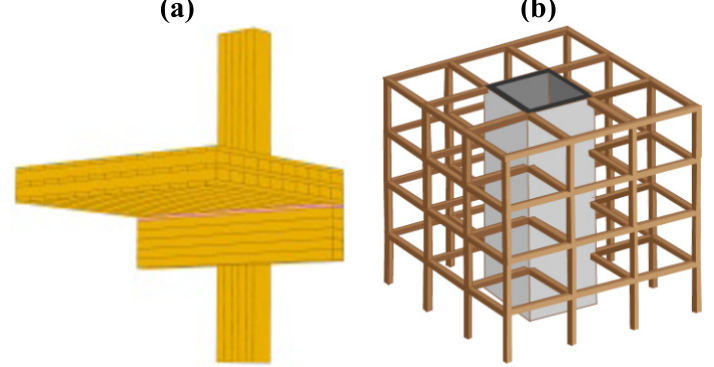
Figure 1. ( a ) Glulam beam and column frame with cross-laminated timber (CLT) floor [8]; ( b ) Glulam frame with concrete shear core